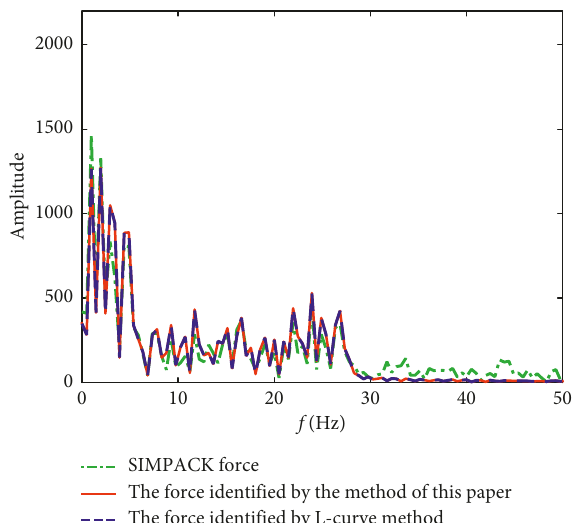
Figure 7: Amplitude-frequency curve of the two methods for F identification when the noise level is 0%.